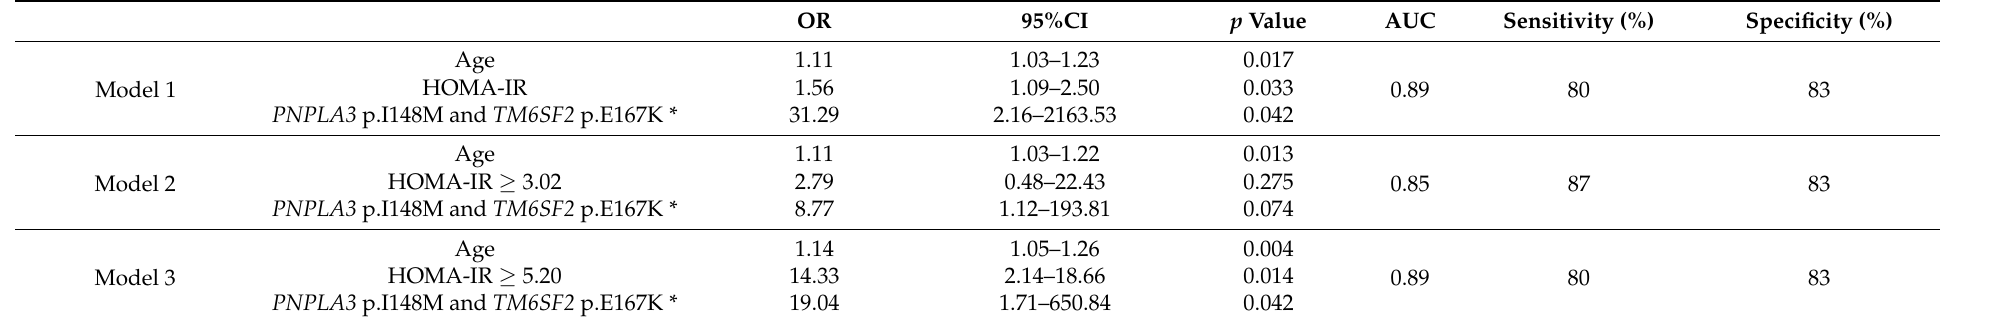
Table 5. Multivariate analysis in non-diabetic NASH patients for developing advanced liver